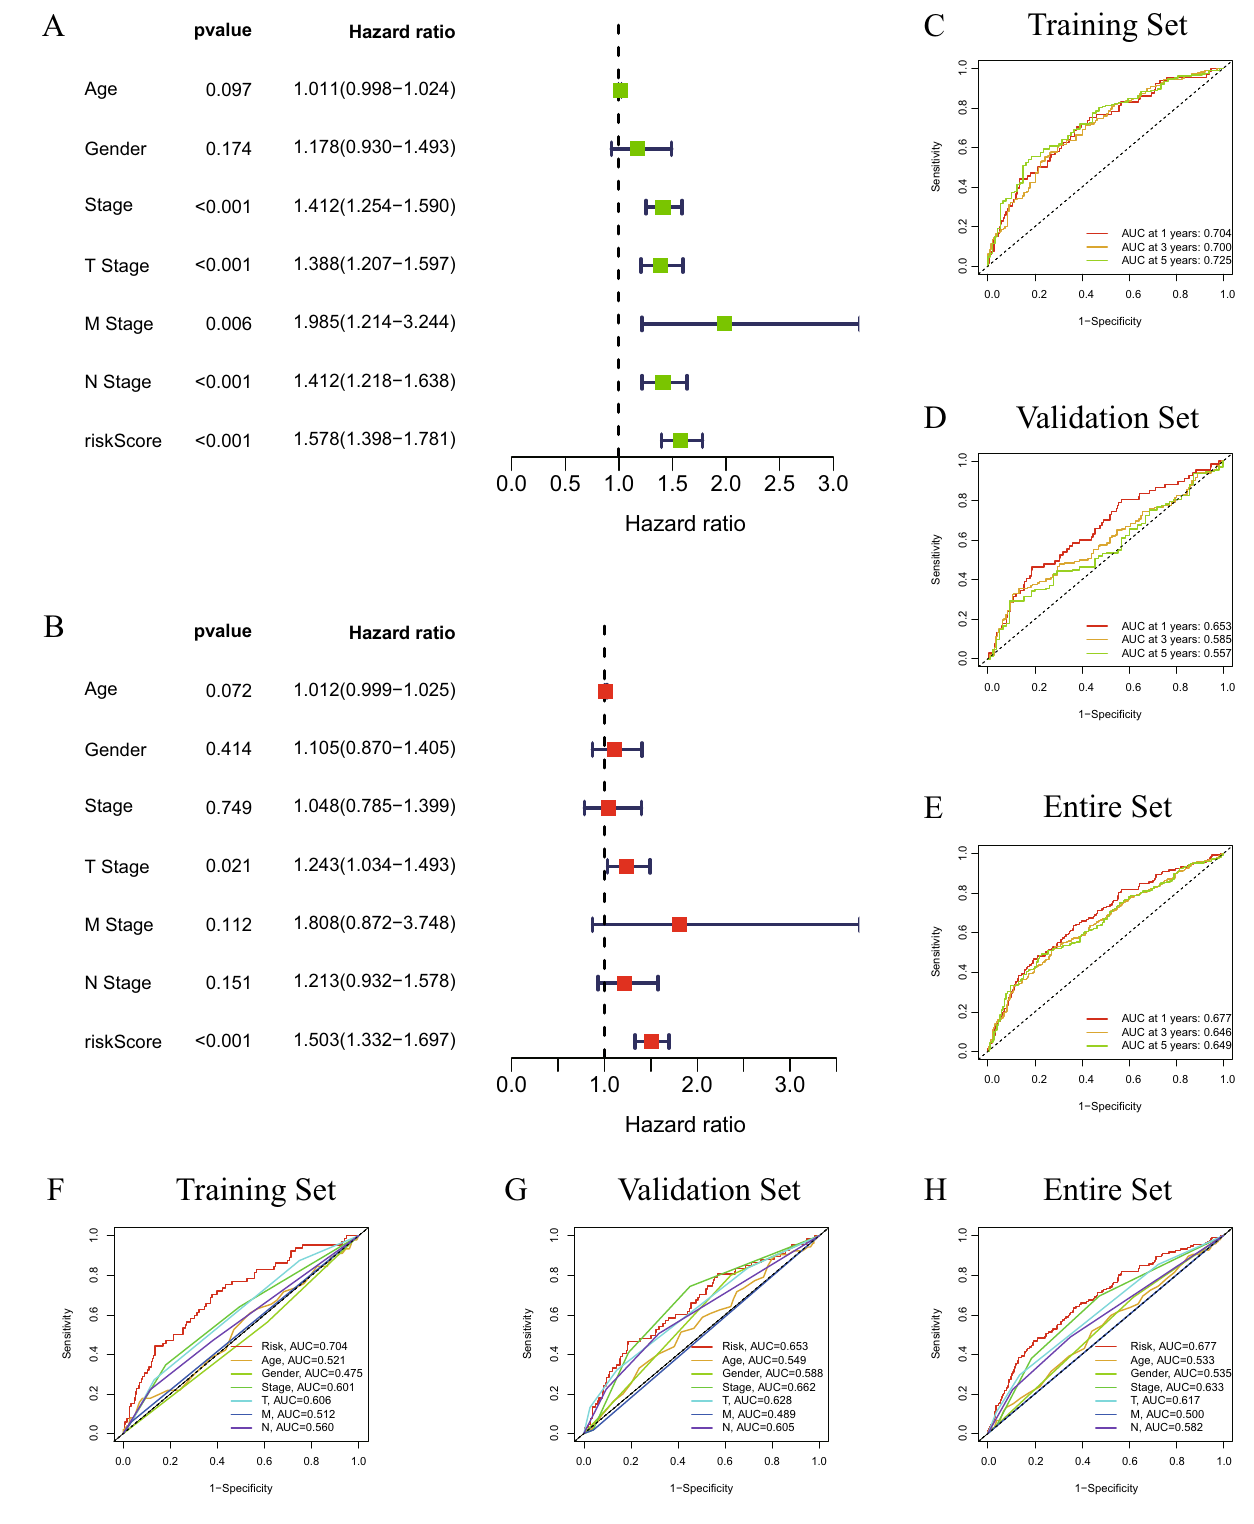
Figure 4. Forest diagrams of univariate ( A ) and multivariate ( B ) Cox regression analyses illustrate that the risk score is an independent prognostic factor in lung cancer. The ROC curves of the 1-year, 2-year and 5-year survival rate in the training set ( C ), validation set ( D ) and entire set ( E ). The ROC curves of the risk score, age, sex, stage, T stage, N stage and M stage in the training set ( F ), validation set ( G ) and entire set ( H ). ROC, receiver operating